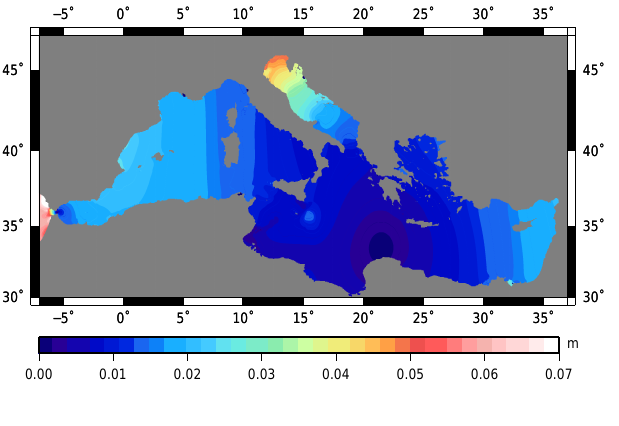
Fig. 10. Amplitude of the O1 constituent.